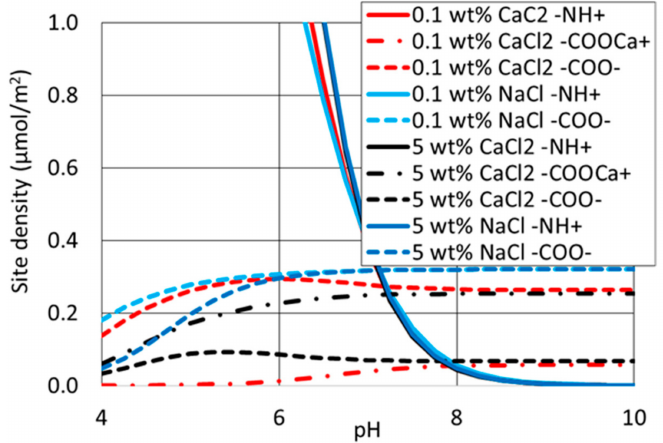
Figure 6. Site density on surfaces of oil/brine vs. pH at various ion type and concentration (this is a plot to particularly observe the site density in a range of 0 to 1 µ mol/m 2